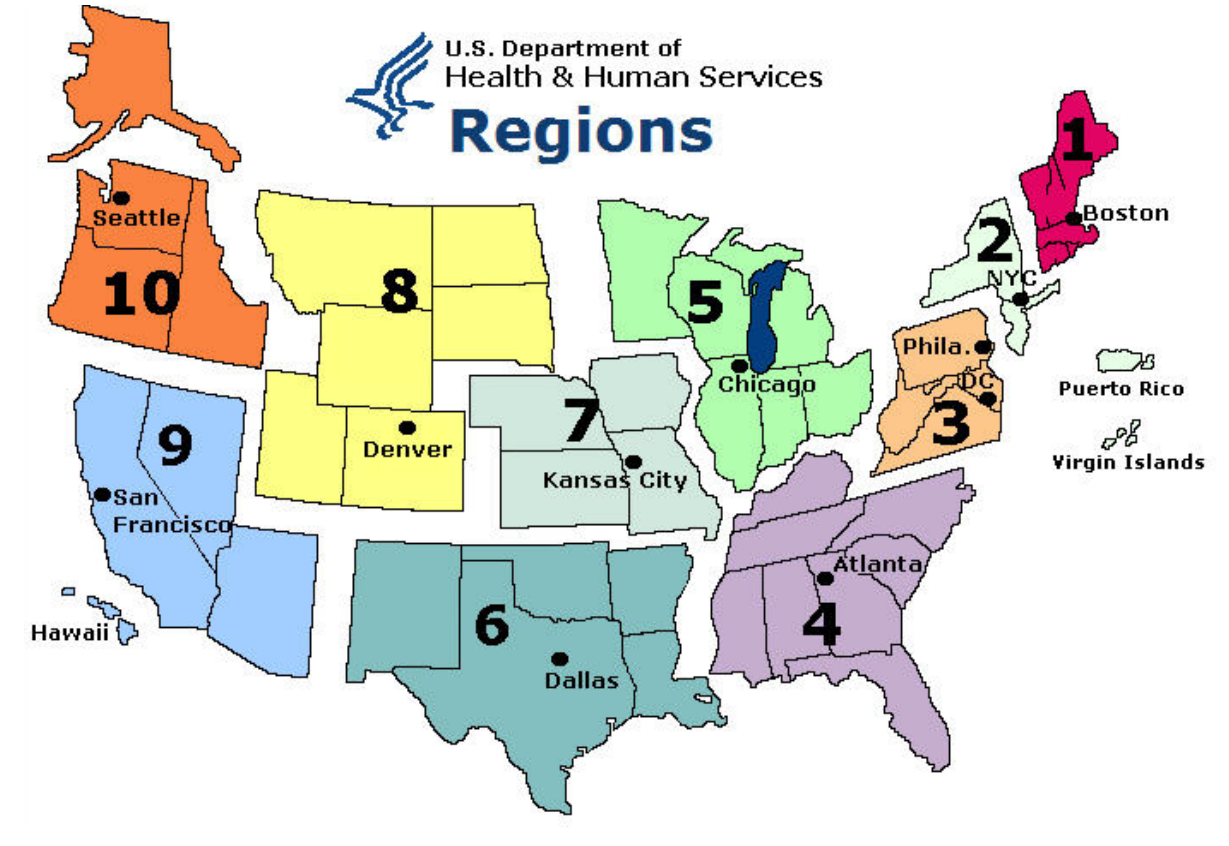
Figure 9. US Department of Health and Human Services